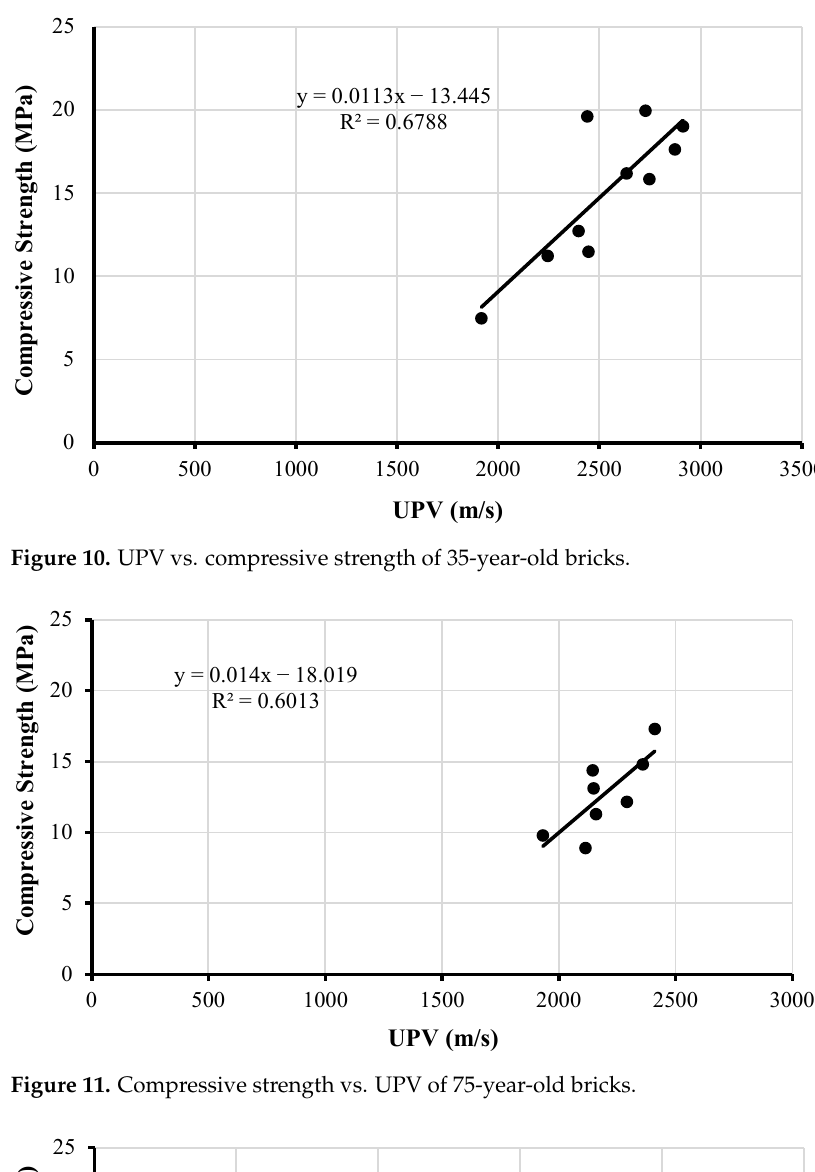
Figure 9. UPV vs. compressive strength of 25-year-old bricks.